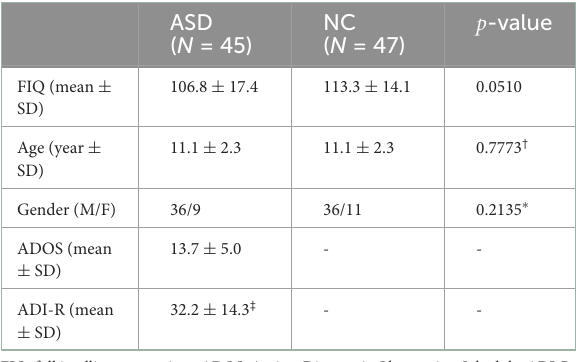
TABLE 1 Demographic information of the